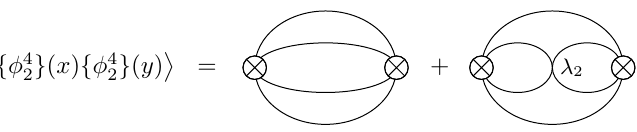
Figure 11 . Leading order diagrams for